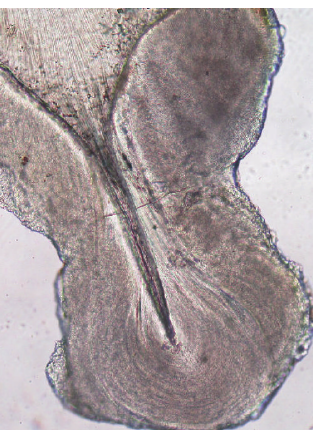
Figure 8: Tomes granular layer (photomicrograph, ground section 10x).